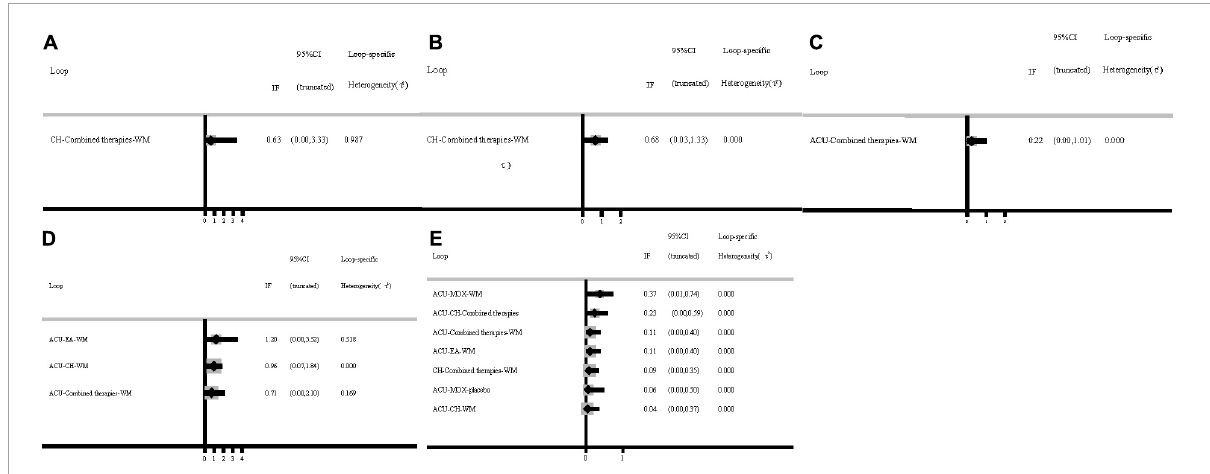
FIGURE4 Inconsistency test. (A) SAS scores; (B) SDS scores; (C) HAMA scores; (D) HAMD scores; (E) response rate. ACU, acupuncture; EA, electroacupuncture; MOX, moxibustion; CH, Chinese herb medicine; WA, warm acupuncture; combined therapies, the combination of acupuncture-related therapies and other therapies; WM, western medicine of anti-diarrheal or anti-spasmodic; placebo, and placebo acupuncture/blank